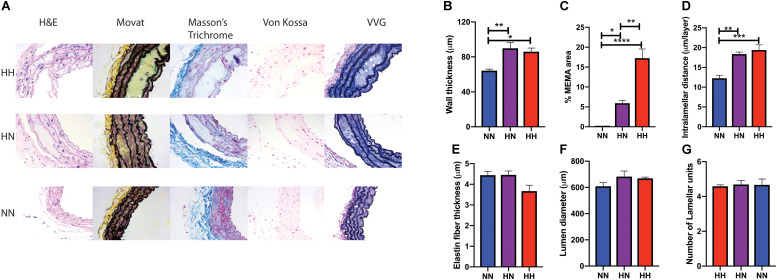
Changes in vascular wall composition and architecture in hypertension reversal. (A) Representative histological staining analysis showing hematoxylin and eosin (H&E), collagen/elastin content (Movat staining), the elastic lamella (Masson’s Trichrome staining), calcifications (von Kossa), and elastin (van Gieson) for the three groups (n = 5 per cohort). (B) Vessel wall thickness, (C) percent MEMA area normalized to total vessel wall area, (D) intralamellar distance, (E) elastin fiber thickness, (F) vessel lumen diameter, and (G) number of lamellar units in aortas at the end of 8 weeks. n = 5 mice per group; ∗p < 0.05, ∗∗p < 0.01, ∗∗∗p < 0.0003, and ****p < 0.0001 by ordinary 1-way ANOVA.